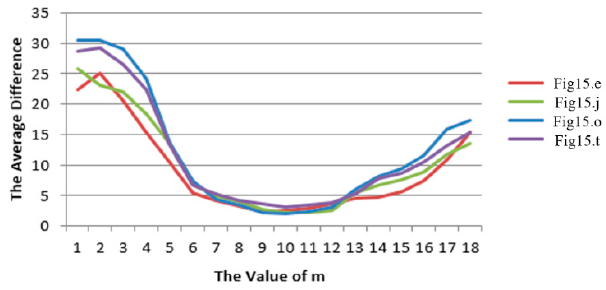
Figure 19. Parameter value analysis: the relationship between m value and average difference.